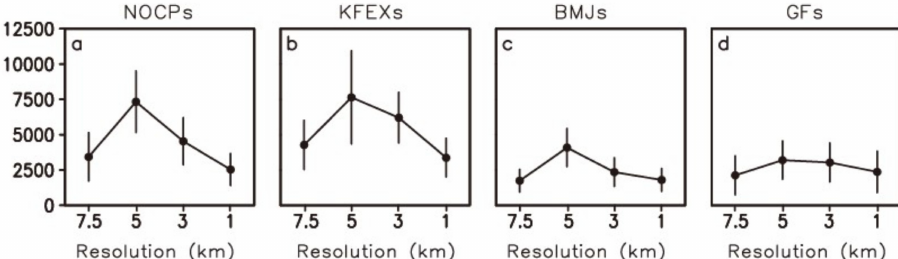
Figure 3. Changes of time-averaged heavy precipitation (greater than 50 mm h − 1 ) area (km 2 ) with resolution in the experiments simulated by ( a ) NOCPs, ( b ) KFEXs, ( c ) BMJs, ( d ) GFs. The time-average interval is one hour. The bar line is a range of one standard